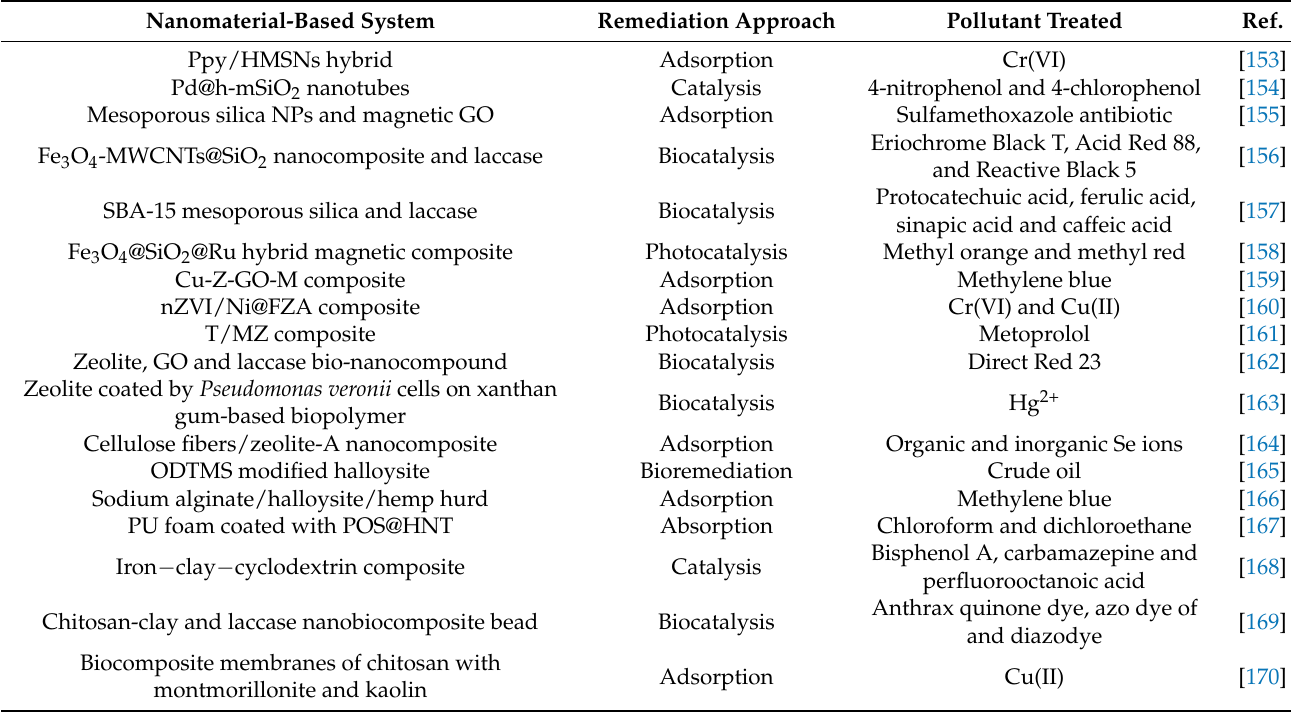
Table 5. Silica-nanomaterial based systems for remediation and bioremediation